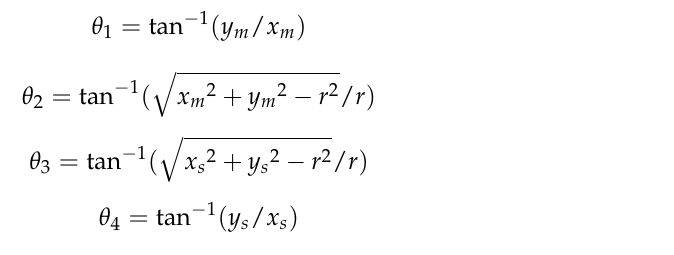
Figure 12. Propagation times of the EM waves by the simulation, experiment and theoretical calculations.